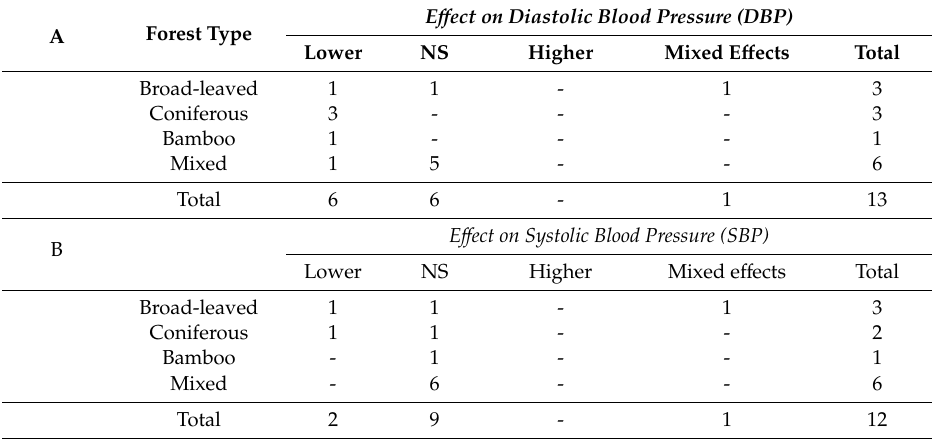
Table 3. E ff ects of forest type on blood pressure in the control trials. (A) Diastolic blood pressure (DBP) and (B) systolic blood pressure (SBP). NS, not